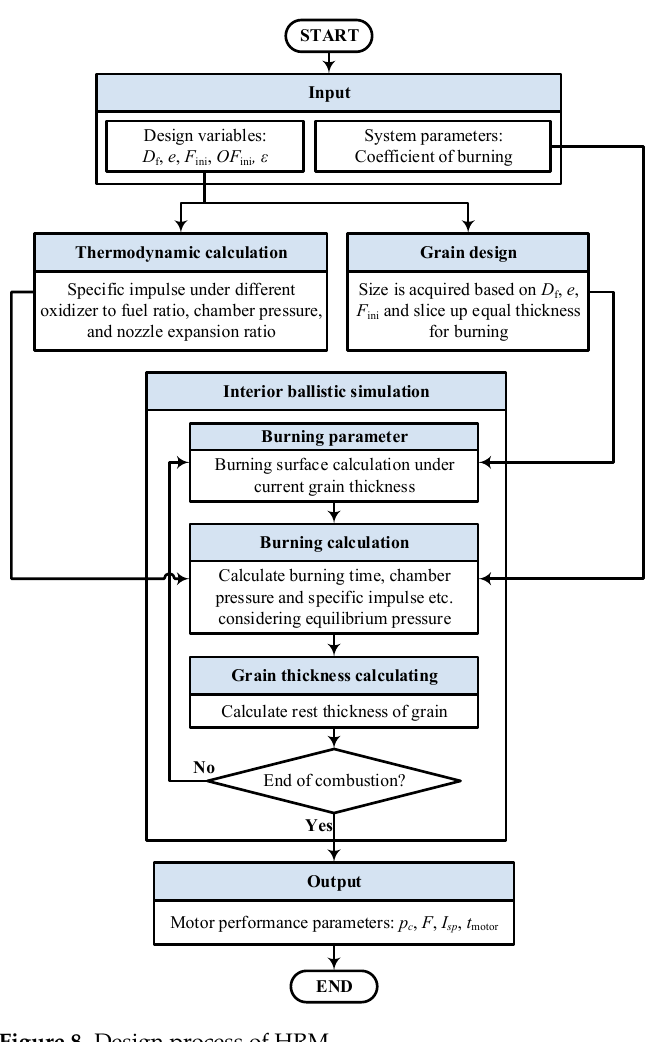
Figure 8. Design process of HRM.